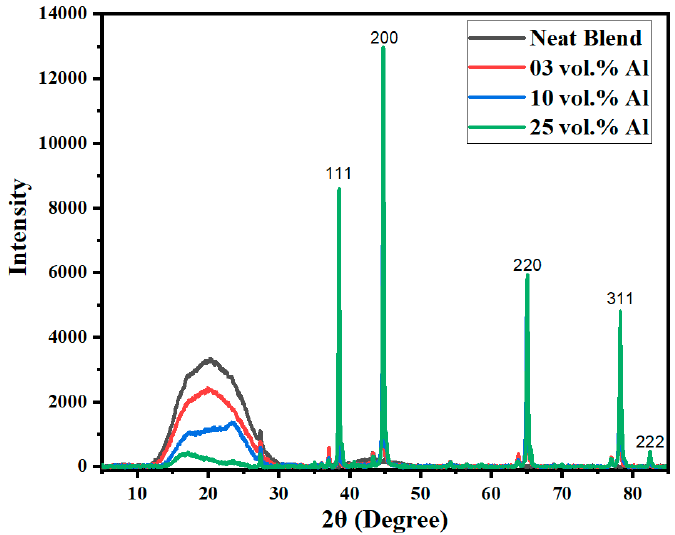
Figure 5 . Wide-angle X-ray diffractograms for bars of Al nano platelet 60/40 PBT/PET composites showing the polymer and Al peaks. The polymer blend shows an amorphous halo in the skin portion of the bar. The intense peaks with the Miller indices are from the aluminium. Note, however, that the small sharp peaks at 2 θ ~27°, 37°, 44°, 64°, and 77° are artefacts from the sample holder.